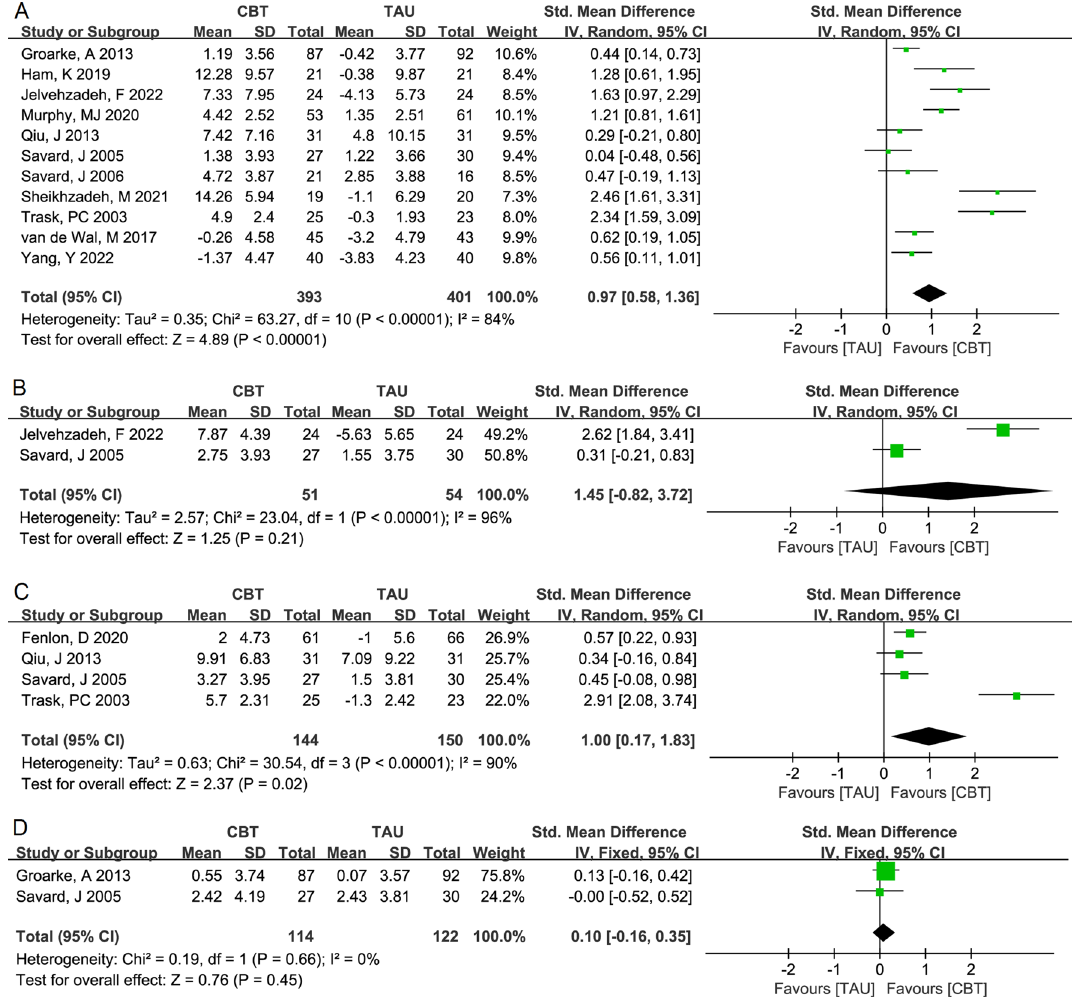
Figure 3. Forest plot of the random effects model meta-analysis of the comparison of the change values of the anxiety scores between CBT and TAU: ( A ) pre-treatment versus post-treatment, ( B ) pre-treatment versus 3-month follow-up, and ( C ) pre-treatment versus 6-month follow-up, and the fixed effects model meta-analysis of the comparison of the change values obtained ( D ) pre-treatment and at the 12-month follow-up. CBT cognitive behavioral therapy, TAU treatment as